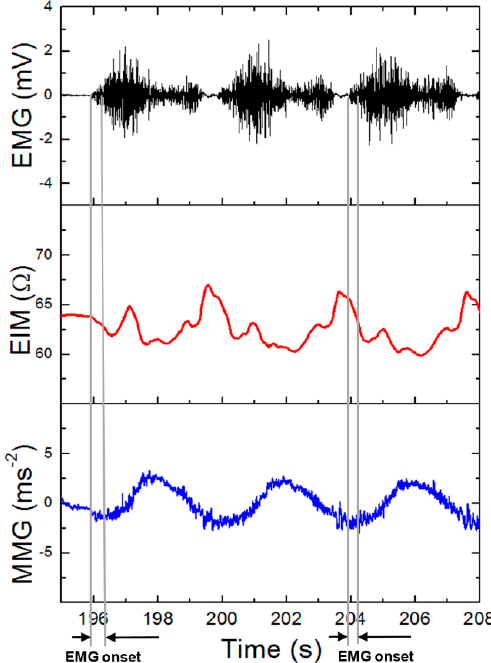
Figure 6. Detailed signal with transition of isotonic movement to isometric.